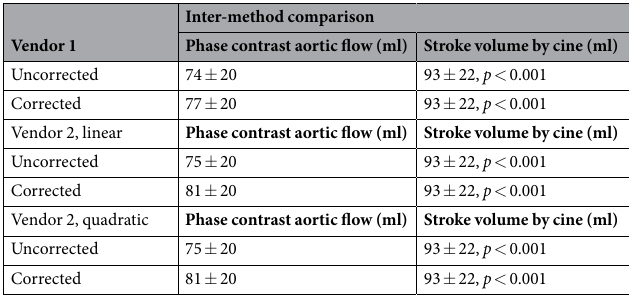
Table 4. Inter-method comparison of aortic flow. P -values denote paired